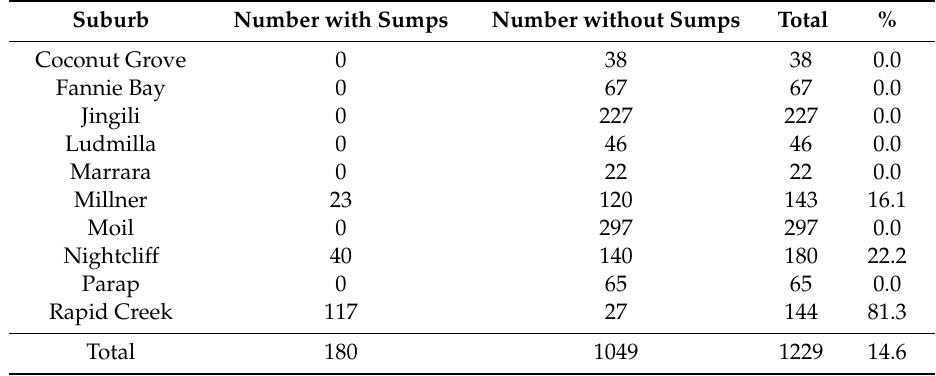
Table 3. Total number of side entry pits inspected by suburb, and number of pits with or without sumps by suburb. All sumps were rectified by concrete filling.